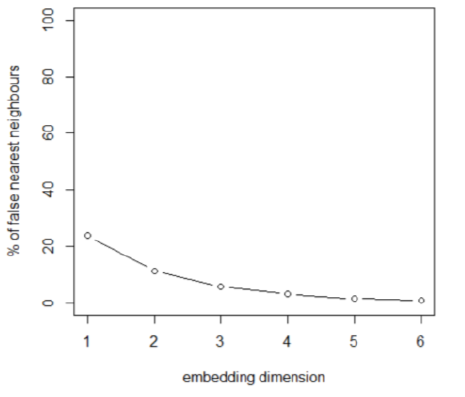
Figure 9: False nearest neighbours-Natural Gas; Source: Author